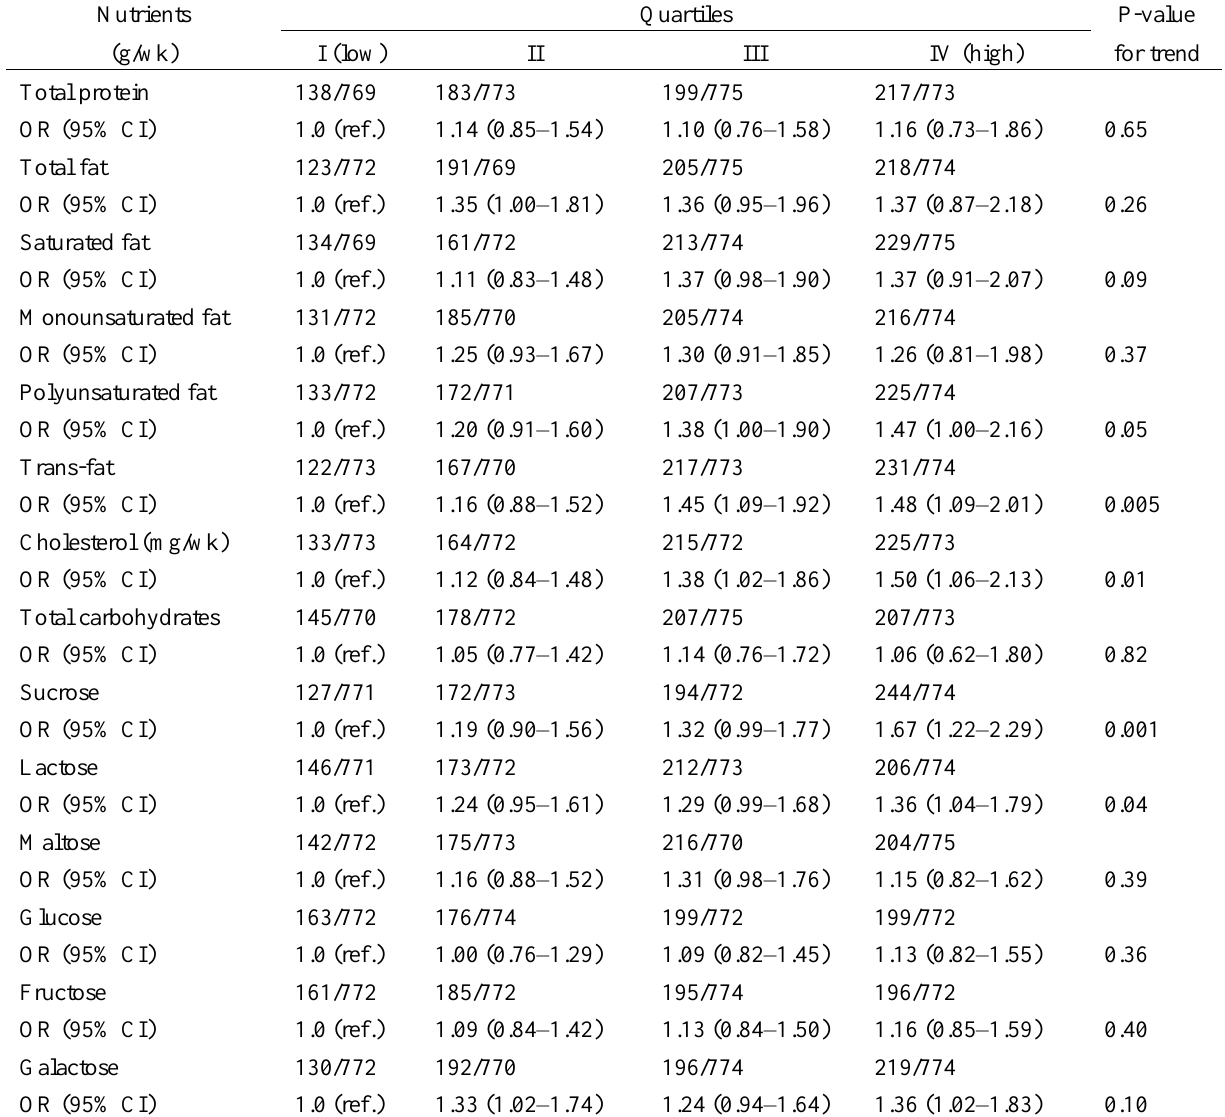
Table 3. Odds ratios* and 95% confidence intervals of fats, protein, cholesterol and carbohydrates for proximal colon cancer, NECSS, Canada,